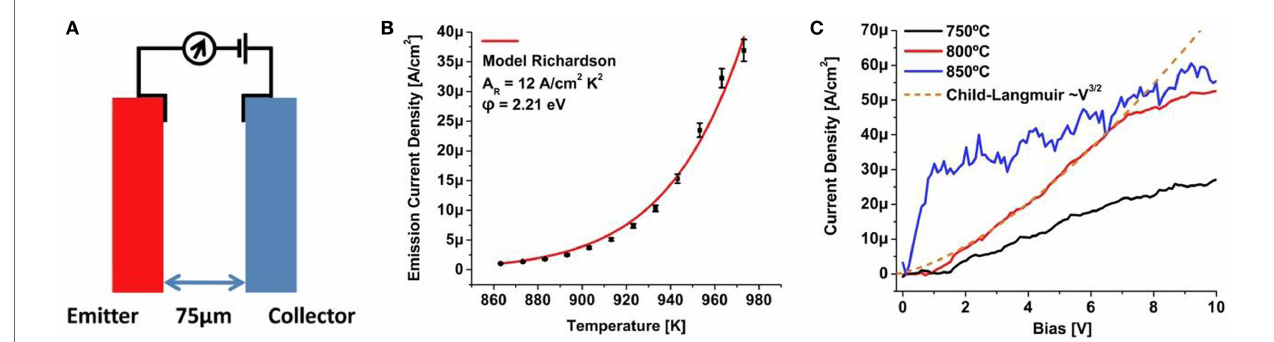
FIGURE 10 | Schematic of a thermionic converter cell utilizing a nitrogen-doped diamond emitter and phosphorus-doped diamond collector (A) with emitter thermionic characterization (B) and thermionic current flow through the converter by application of a bias to mitigate space charge that indicates a Schottky barrier at the collector at lower temperatures, a space charge regime, indicated by the dashed line at 800°C, and a regime that may be attributed in part to resistivity effects at the doped diamond electrodes and contacts (C)